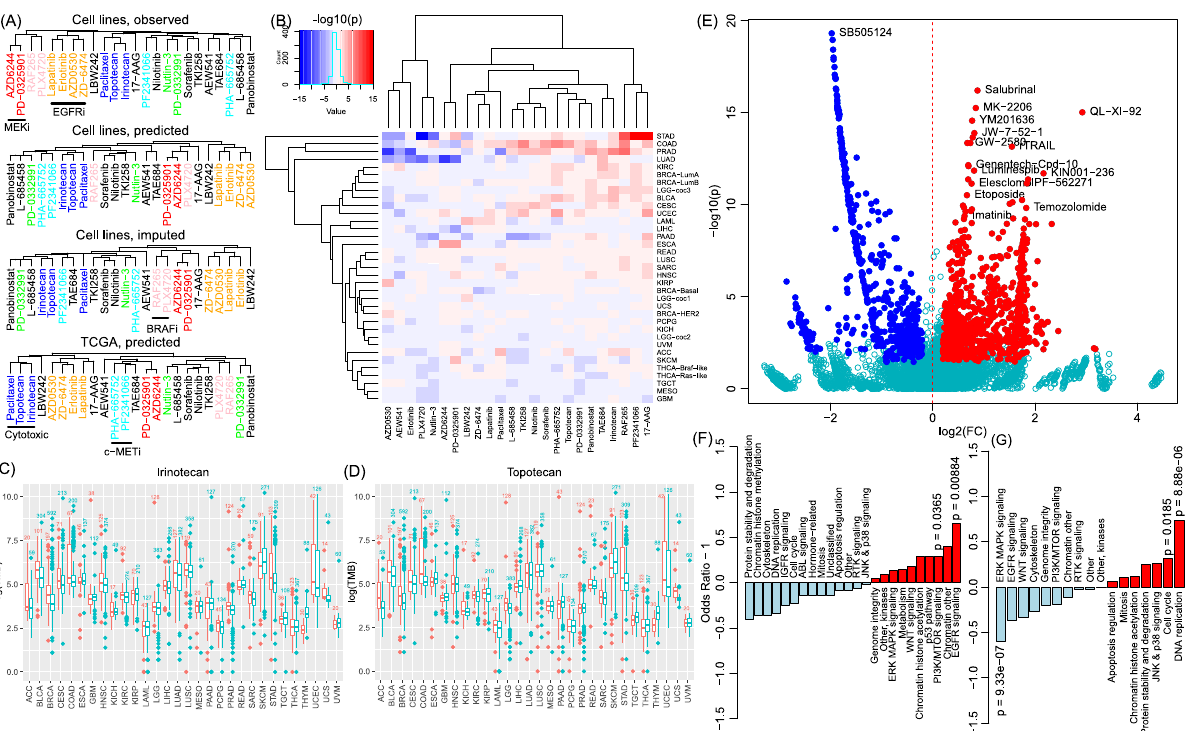
Fig. 6 Drug similarity. A Hierarchy clustering results of the 24 CCLE drugs using four sets of samples: the observed drug response (set 1), the predicted drug response in cell lines with observed data (set 2), the predicted drug response in all 1100 cell lines (set 3), and the predicted drug response in all TCGA cancer samples. B Heatmap showing the association patterns between each drug and the tumor mutation burden (TMB) in CCLE. In each cell, red indicates a positive association (i.e., responders of the cancer type tended to have a high TMB), while blue indicates a negative association (i.e., responder tended to have a low TMB). For each cell, a two-sided t test was conducted by comparing the log10(TMB) of samples from the group with high sensitivity (i.e., “ responders ” , de fi ned as the top 25% samples ordered by decreasing predicted response to the corresponding drug) and the log10(TMB) of the remaining 75% samples. The color was determined by whether the sensitive group had a higher average TMB than the other group. C , D Demonstration of TMB distribution in responders (the 25% samples with the highest response) and non-responders (the remaining 75% samples) using two cytotoxic drugs: irinotecan ( C ) and topotecan ( D ). Each box shows the interquartile range (IQR between Q1 and Q3) for the corresponding set. The central mark (horizontal line) shows the median and the dots show the rest of the distribution based on IQR (Q1 − 1.5 × IQR, Q3 + 1.5 × IQR). E Distribution of the association between GDSC drugs and TMB. Because TMB varied dramatically across cancer types, we conducted the test within each cancer type. Each dot represents a GDSC drug in a cancer type. The P value was similarly calculated as in ( B ). x axis is the log2 form of fold change (FC) de fi ned as the average TMB of the responder group over the average TMB of the nonresponder group. Y axis indicates – log10 form of the unadjusted P value (for plotting only). Red and blue dots indicate signi fi cant associations ( P BH < 0.05 and log2FC> 0.2). F , G Enrichment of drug classes in the group of drug-cancer type associations with negative association patterns (blue dots in E ) and with positive association patterns (red dots in E ). The P values were obtained from a two-sided Fisher ’ s exact test to assess whether a drug class was overrepresented with the negative/positive